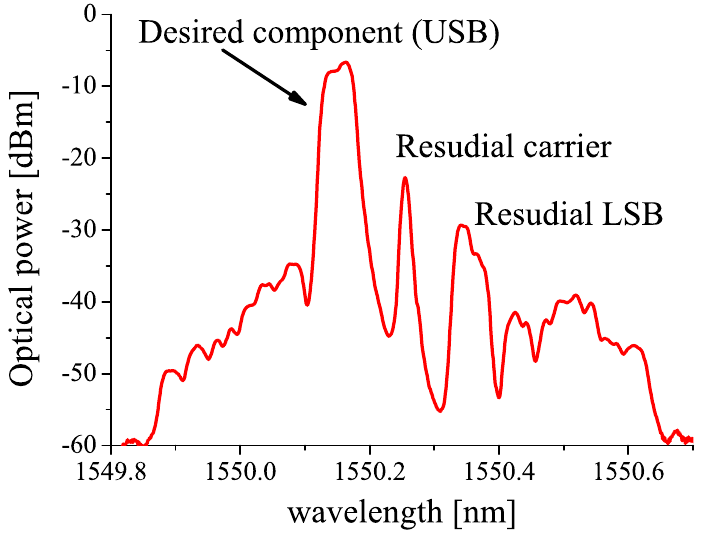
Figure 19. Output optical